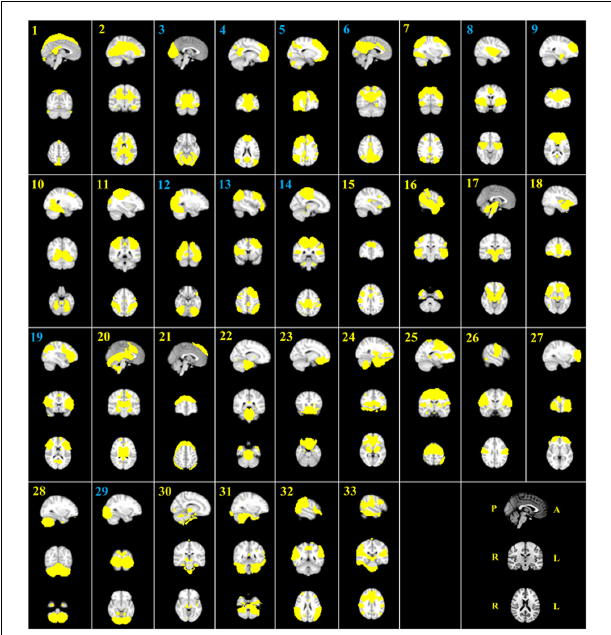
FIGURE 1 | The 33 automatically generated ICs by group ICA. All ICs were threshold at z -statistic images with p > 0.5. The indices of eleven functionally interpretable ICs were reported in blue. P, posterior; A, anterior; R, right; L,